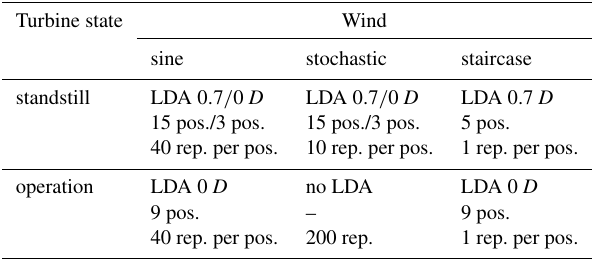
Table 1. Experimental test cases including number of measurement positions of the LDA and repetitions.